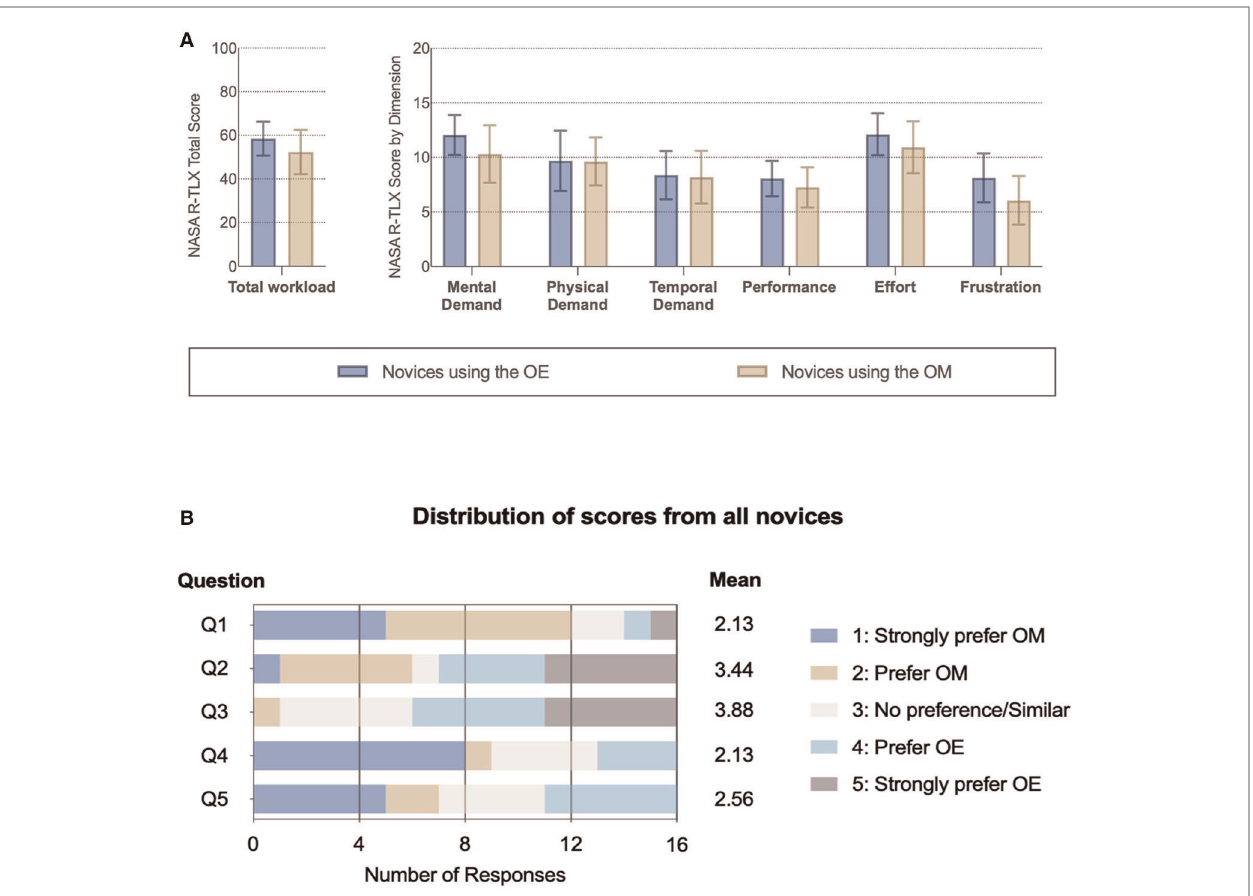
FIGURE 4 | Subjective impression of the optical device. ( A ) NASA Raw Task Load Index (NASA R-TLX) score for each dimension and total workload compared between novices with different instruments. ( B ) Subjective questionnaire ( Supplementary Material Table 2 ): Q1: better visualization; Q2: greater freedom of movement; Q3 more comfortable; Q4: easier to perform a task with; and Q5: prefer to use in the